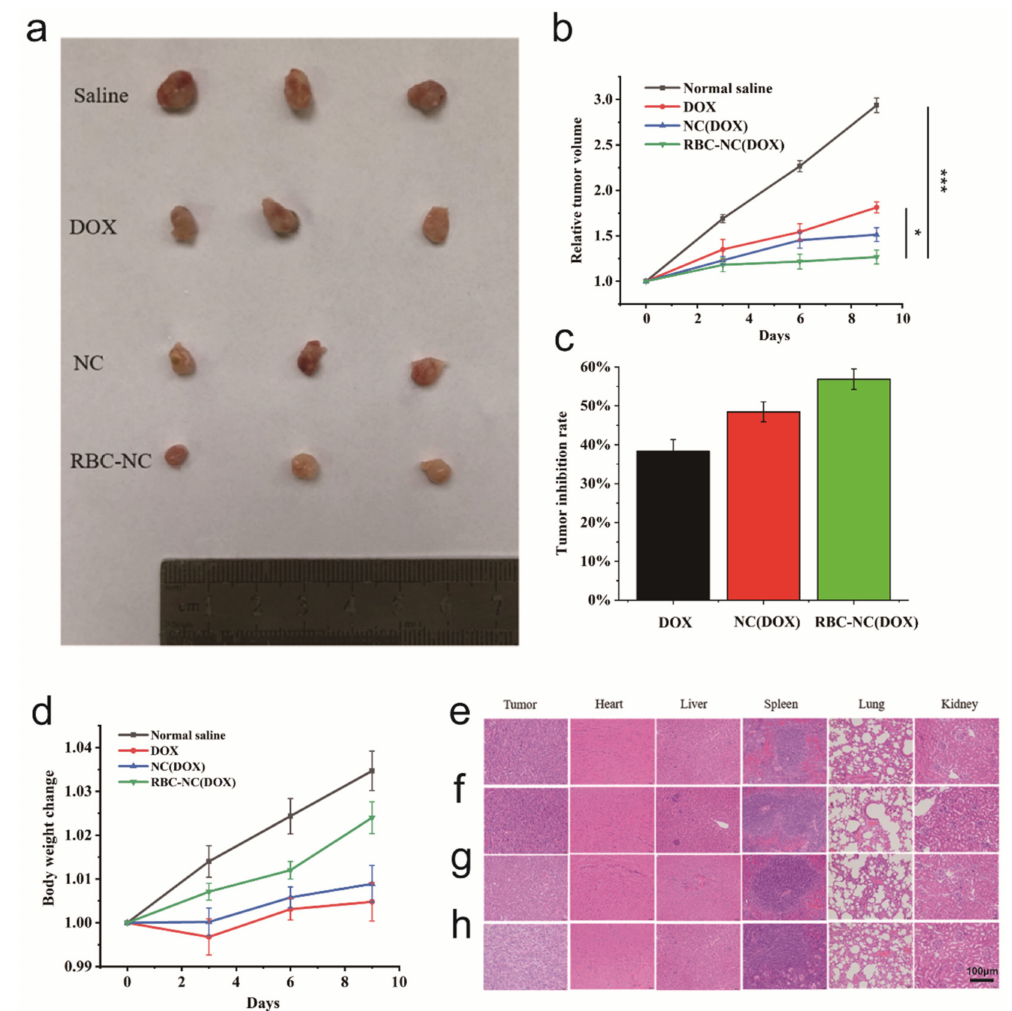
Figure 5. ( a , b ) Actual tumor morphology changes. ( c ) Tumor growth inhibition in mice treated with normal saline, free DOX, NC(DOX), and RBC-NC(DOX) by tail vein injection. ( d ) Body weight change over time. ( e – h ) H&E-stained histological sections. ( e ) Normal saline, ( f ) Free DOX, ( g ) NC(DOX), and ( h ) RBC-NC(DOX). Error bars represent standard deviations (n = 6). * and *** indicate p < 0.05 and p < 0.001,